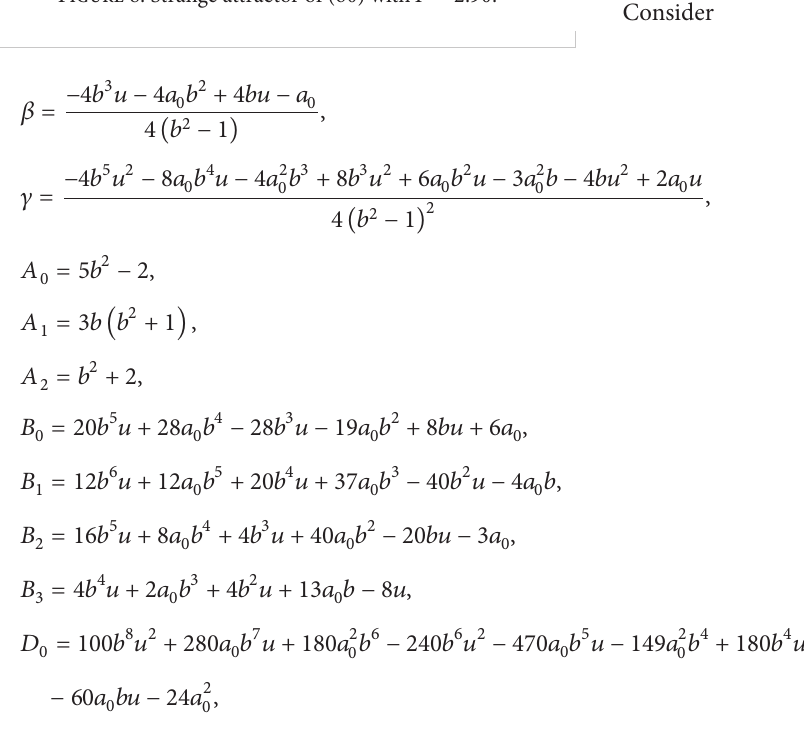
Figure 8: Strange attractor of (60) with 𝐹 = 2.90